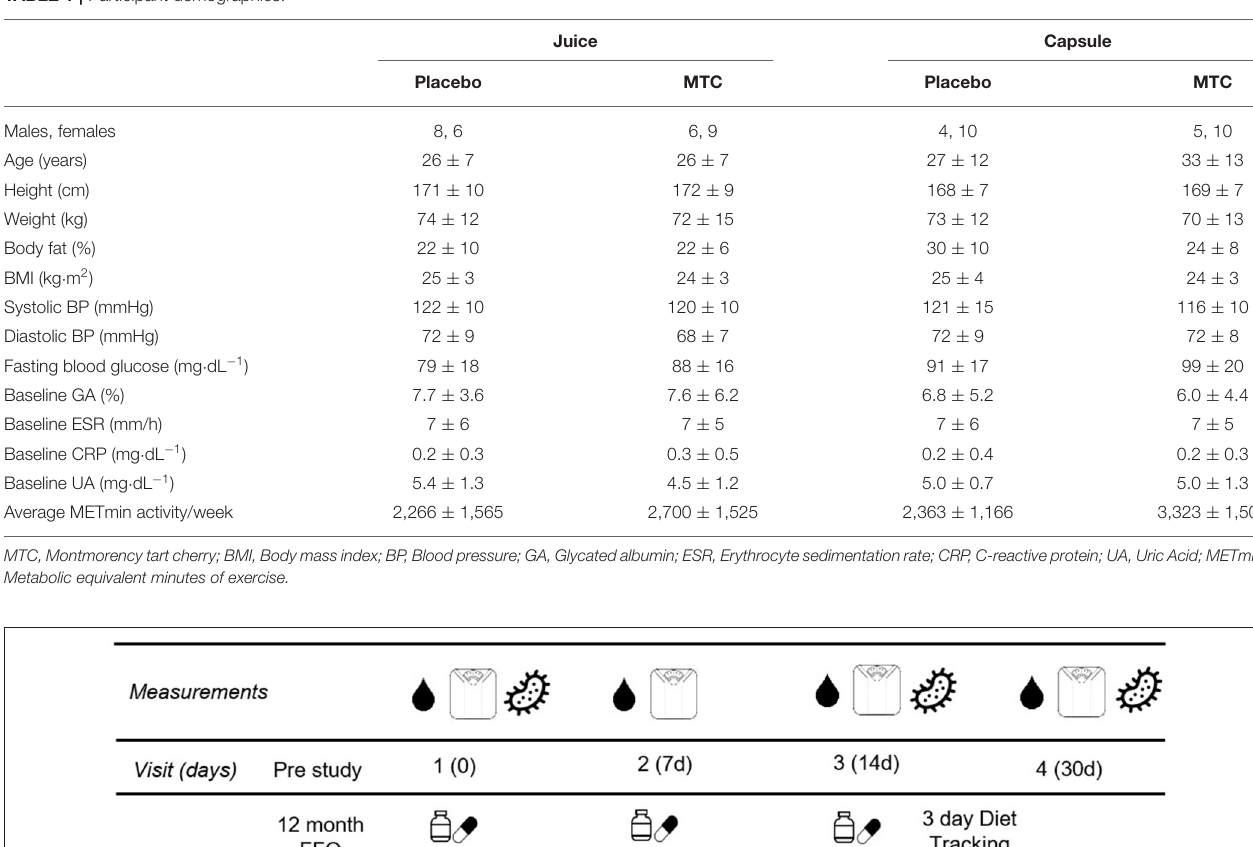
TABLE 1 | Participant demographics.